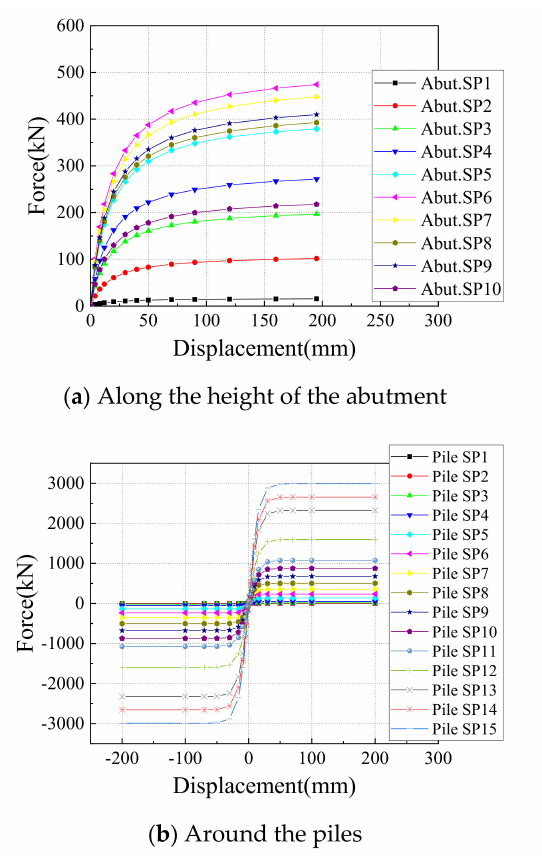
Figure 3. Force–displacement relationship of the soil